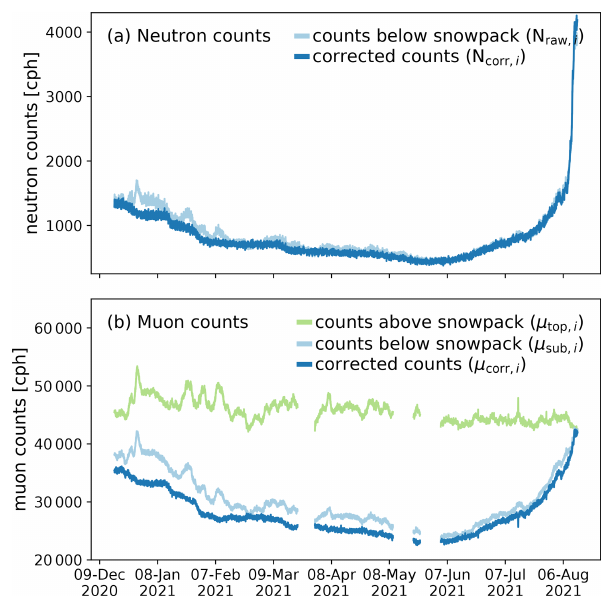
Figure 2. Neutron and muon counts from 16 December 2020 to 13 August 2021. Panel (a) shows neutron counts from the n-CRSG and (b) muon counts from the µ -CRSG during the same time pe- riod. Please note the different scales for the y